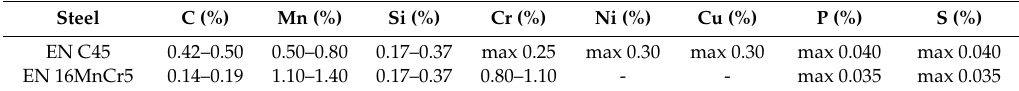
Table 2. Chemical composition of the steels.